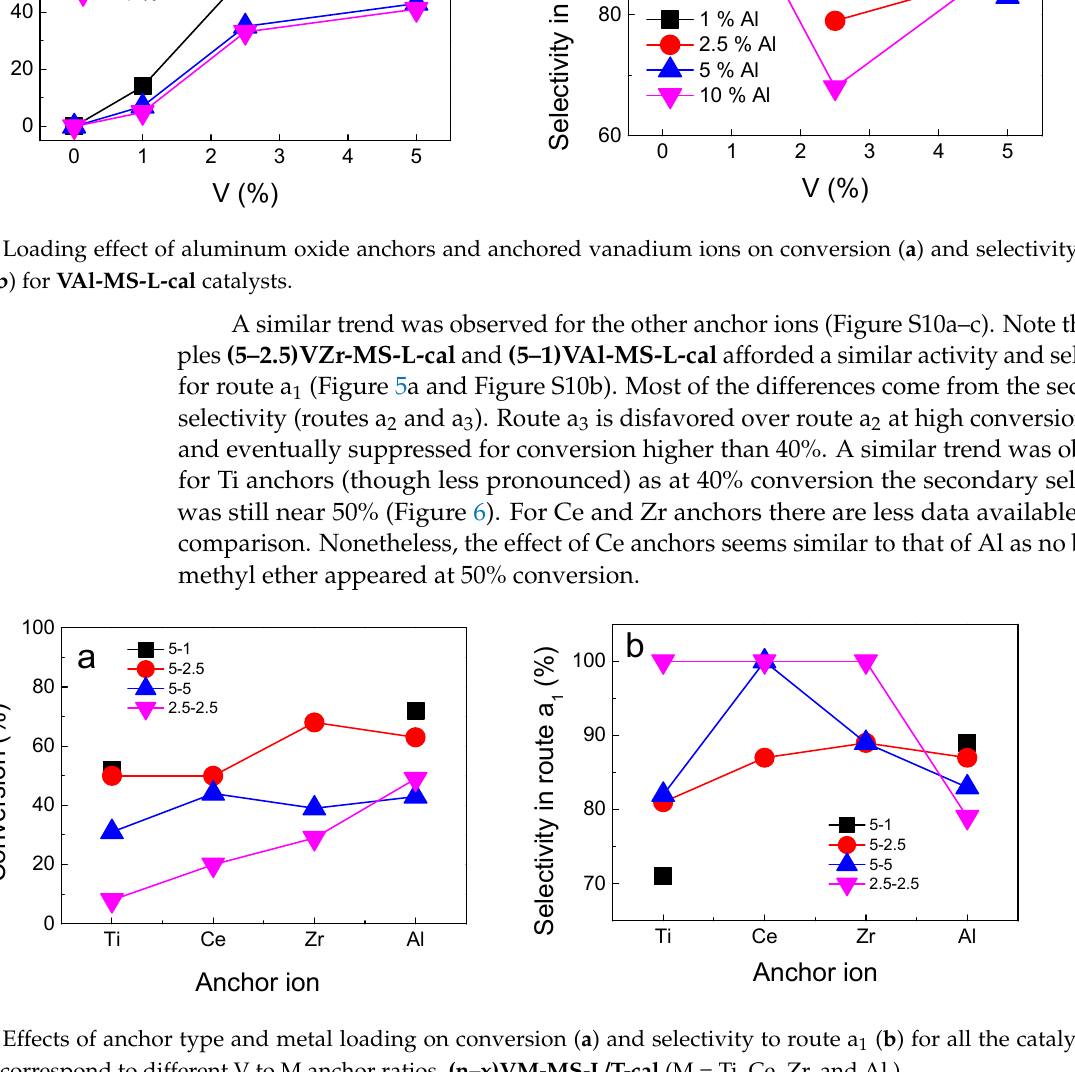
Figure 4. Loading effect of aluminum oxide anchors and anchored vanadium ions on conversion ( a ) and selectivity to route a 1 ( b ) for VAl-MS-L-cal catalysts.